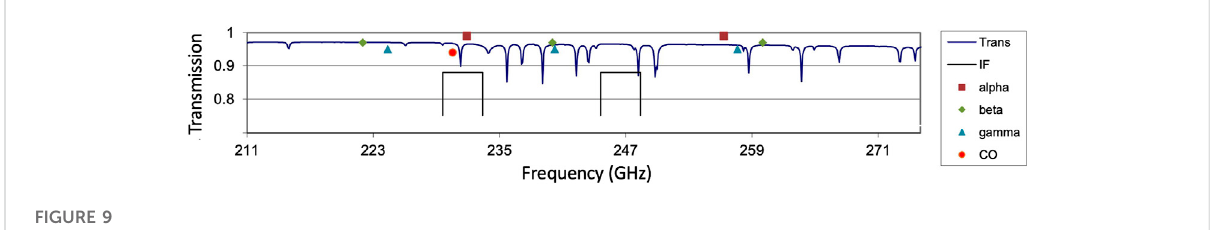
FIGURE 9 Lines present in the ALMA Band 6 frequency range. The blue line indicates the atmospheric transmission and the black brackets indicate the current locations of the upper and lower sidebands for solar observing. The legend indicates the frequencies of the H α , H β , and H γ radio recombination lines as well as CO. Note that the lower sideband was selected to include H30 α recombination line and the CO J = 2-1 line. Adapted from an unpublished fi gure provided to the authors by R.